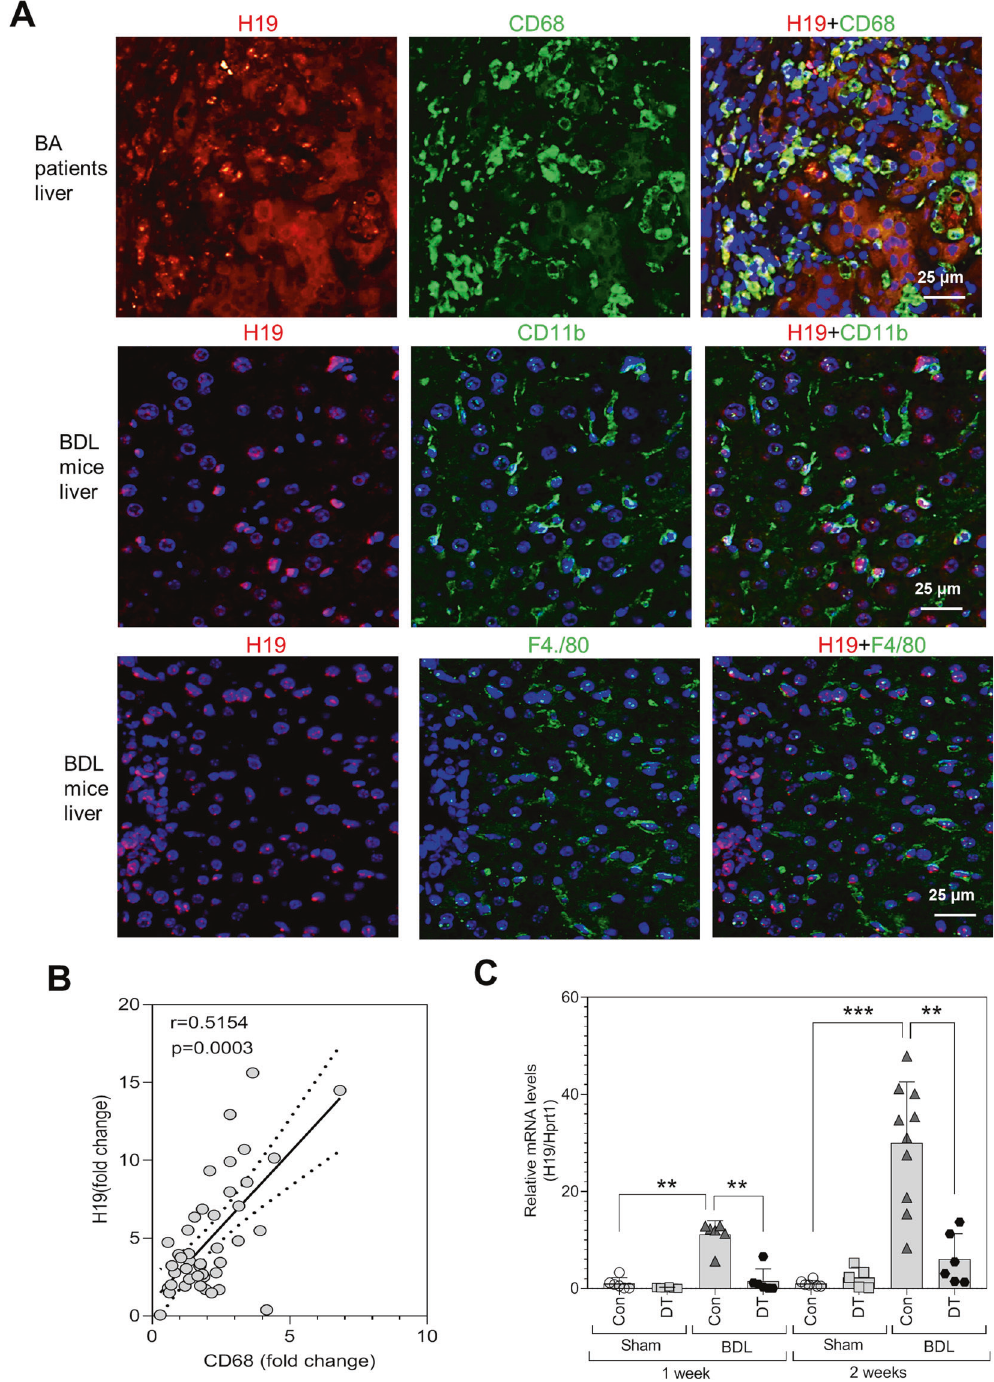
Fig. 4 Macrophage depletion reduces the H19 expression in the cholestatic livers. A H19 Fluorescence in situ hybridization (FISH) and immuno fl uorescence (IF) co-staining showed H19 presented in CD68 + macrophages in livers of BA patients and H19 FISH and CD11b, F4/80 co-staining in the liver sections of BDL mice. Scale bars: 25 μ m. B Hepatic levels of CD68 were positively correlated with the expression of H19 in livers of BA patients. C Relative mRNA levels of H19 in livers of Sham, Sham + DT, BDL, and BDL + DT ( n = 5 – 11) were determined by RT- PCR. Hprt1 was used as an internal control. Data were expressed as mean ± SD. ** P < 0.01, *** P <